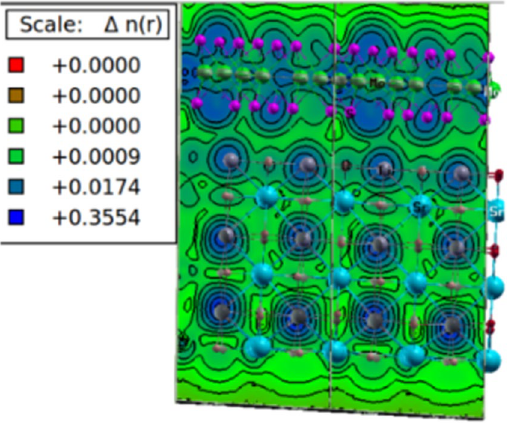
Figure 9. Charge density of TiO 2 terminated HS in (010) plane. The color plate is at right side showing the charge transfer and bonding character at the interface. Atoms are presented as; Blue balls- Sr, Gray balls- Ti, Red balls- O, Magenta balls- S and Green balls-